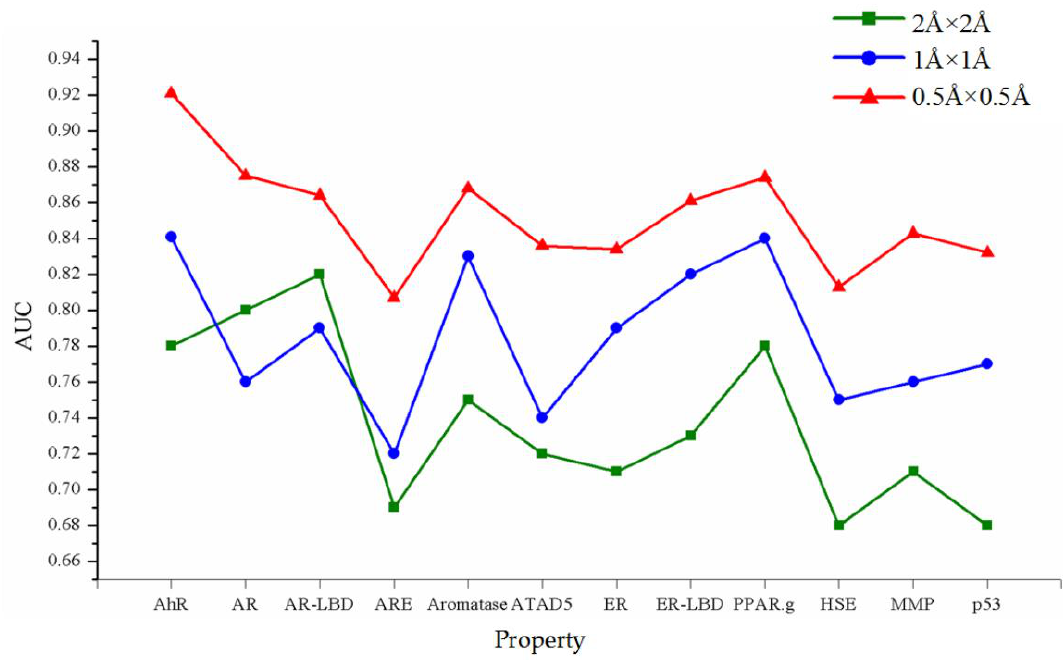
Figure 10. The results of the different resolutions. The red line represents the result of the resolution of 0.5Å × 0.5Å , while the yellow and green lines represent 1Å × 1Å and 2Å × 2Å respectively.